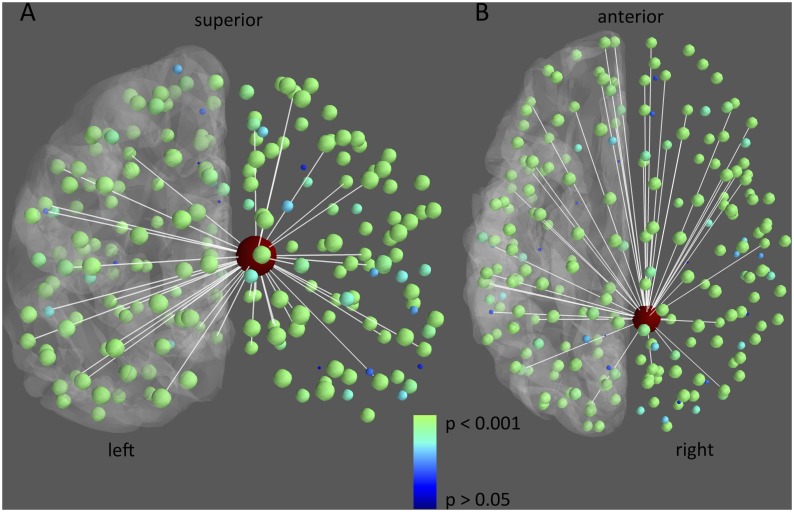
Differences in resting-state flexibility of connections from the cPCC between memory preserved and disturbed patients.The 5% largest differences in connections between memory preserved and memory disturbed LTLE patients (i.e. preserved—disturbed) are depicted in white. Furthermore, nodal group differences in flexibility with the cPCC (large node in red) are depicted in color and size, with smaller blue nodes indicating no significant difference (P > 0.05), and bigger green nodes referring to significant decreases in resting-state flexibility in the memory disturbed patients (P < 0.001). For reference, the left cortical surface is displayed in grey.